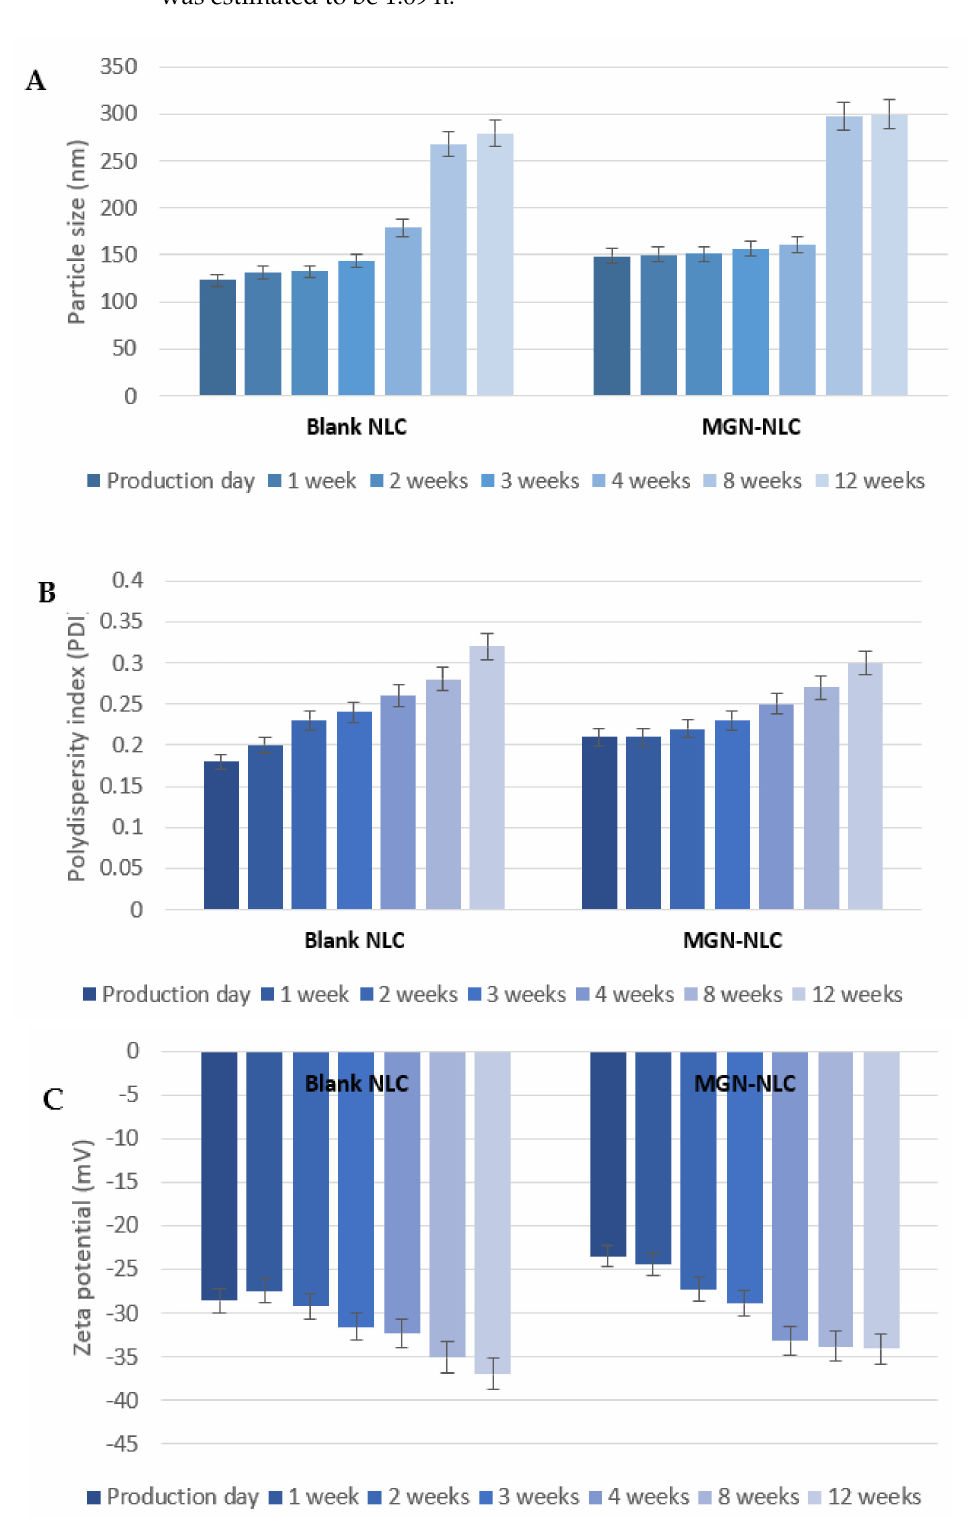
Figure 3. ( A ) Particle size, ( B ) polydispersity index (PDI) and ( C ) Z-potential of blank and MGN–NLC during 12 weeks of storage at 25 ◦